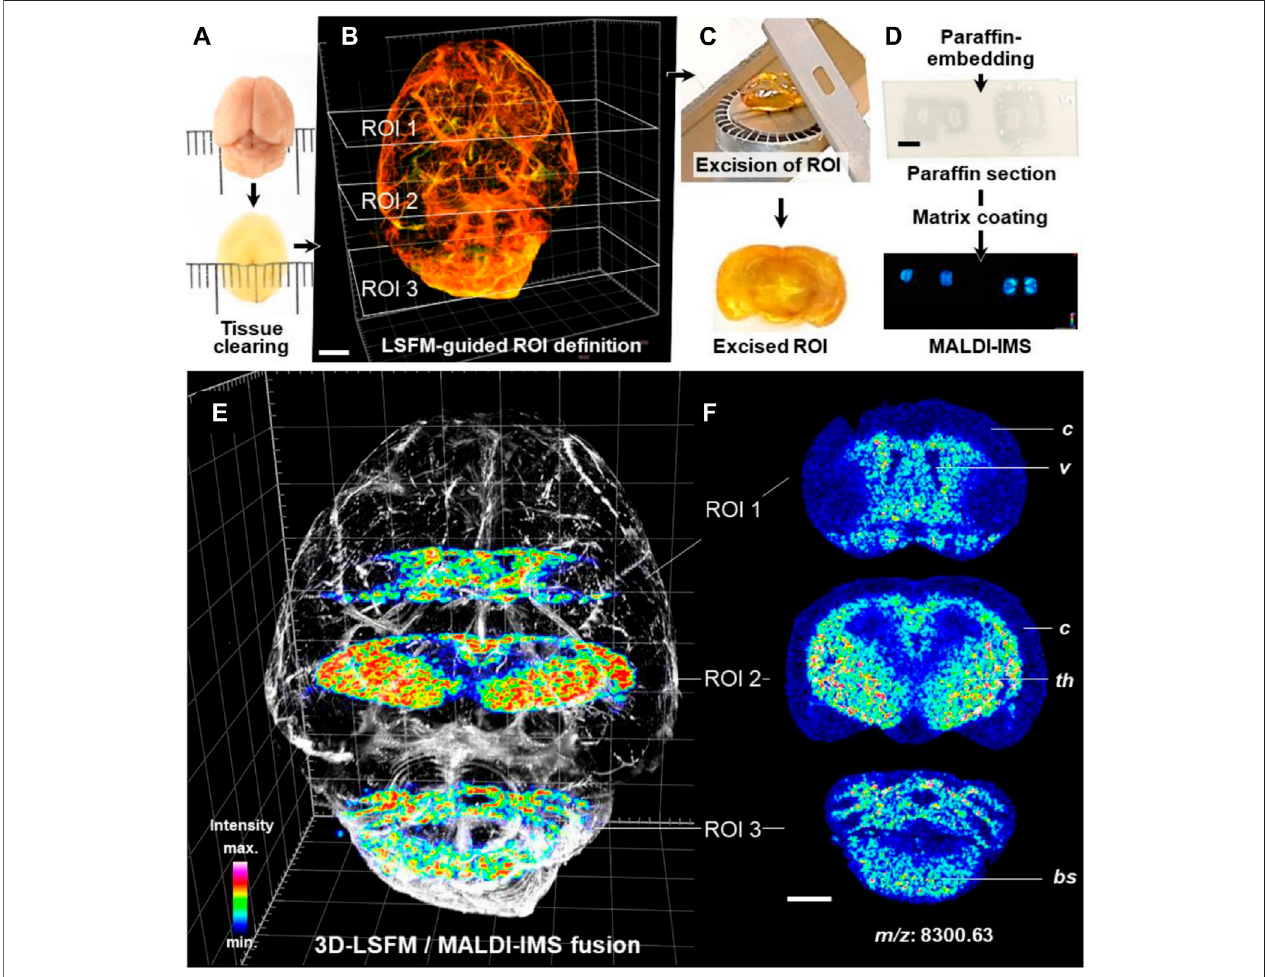
FIGURE 11 | 3D-LSFM-guided MALDI-MSI in an optically cleared mouse brain (Blutke et al., 2020). (A – D) Sequence of tissue-processing steps. (E) Fused image of the 3D-LSFM reconstruction of the cleared brain and MALDI-MS images of guanine nucleotide-binding protein subunit gamma-3 (GNG3, m/z : 8,300.63). (F) MALDI- MS images of GNG3. The spatial distribution of GNG3. Distinct brain structures are indicated for orientation: cerebral cortex ( c ), ventricles ( v ), thalamus ( th ), brain stem ( bs ).